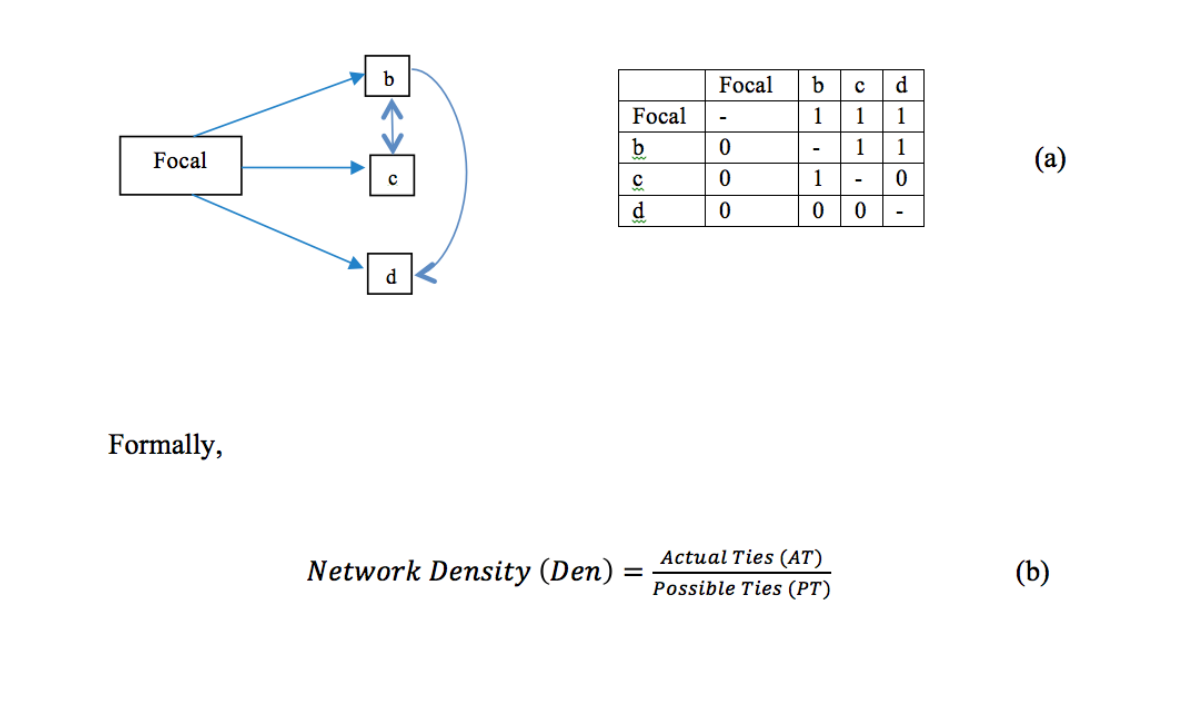
Table 1. Comparison between the numbers of ties involving and not involving the focal organization.